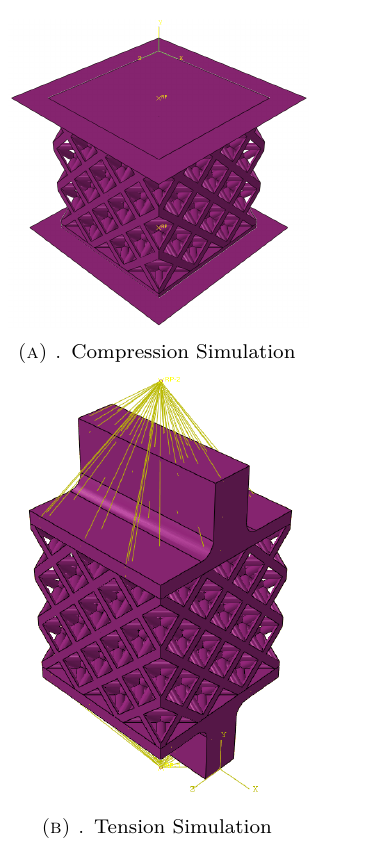
Figure 5. Simulation Setup